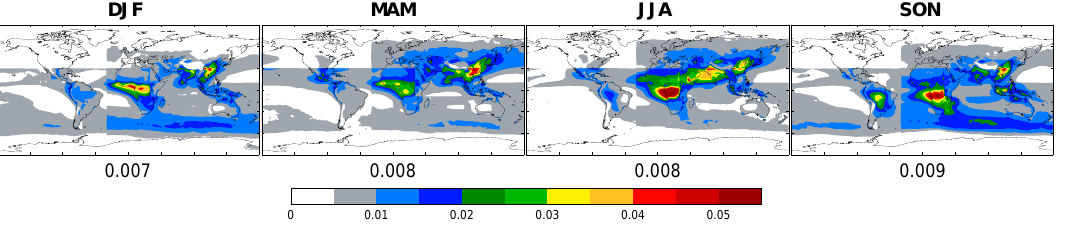
Fig. 3. Seasonal distributions of total absorption AOD at 0.55µm as derived from the MACC re-analysis over 2003–2010. Global averages are given by the numbers below each panel.